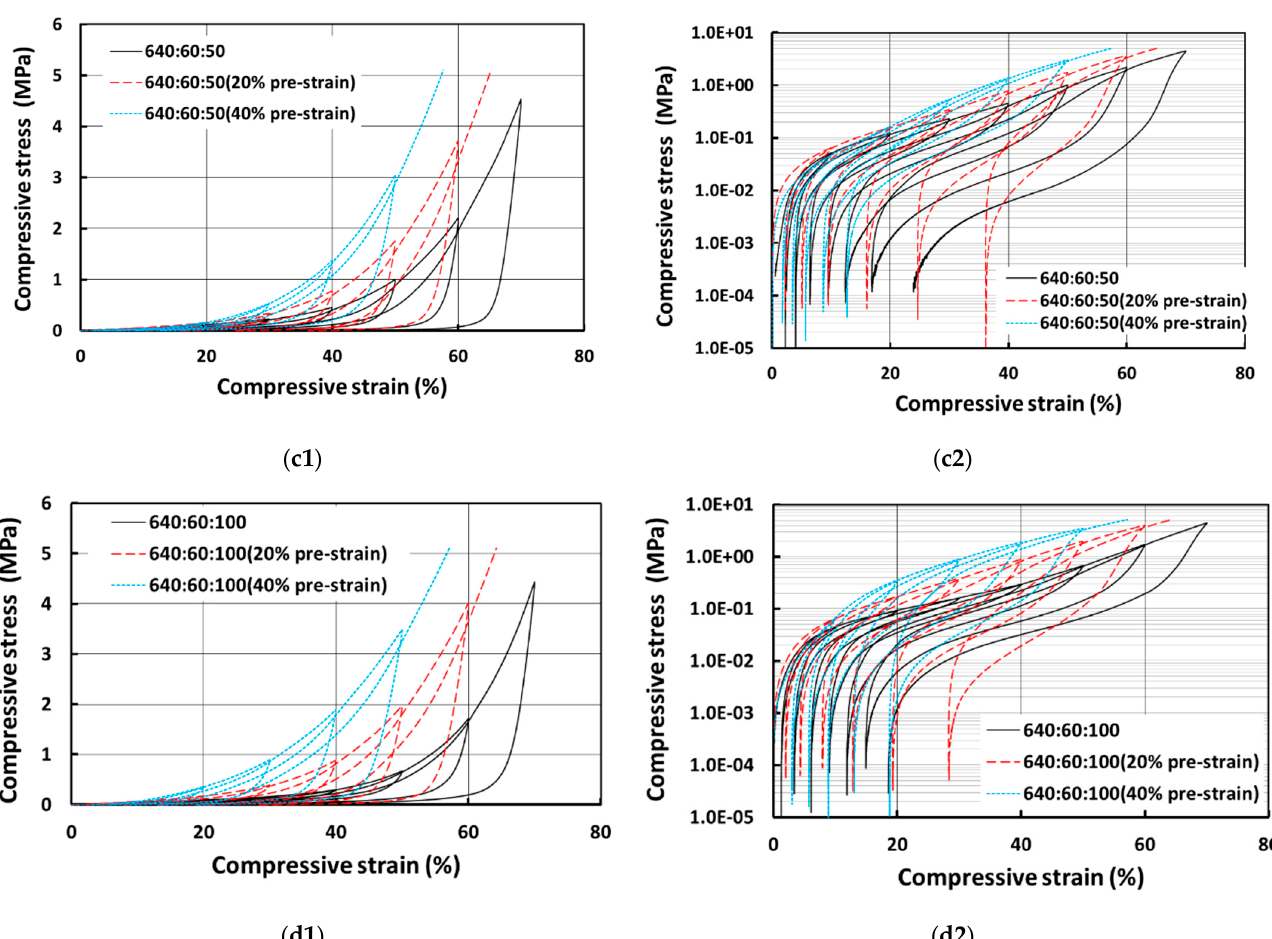
Figure 14. Compressive stress vs. strain of E640 SMH samples with 0%, 20% and 40% pre-strains; ( a1 ) for samples with 70% silicone, 30% PCL and 50% wetting hydrogel and its corresponding logarithmic plot of stress in ( a2 ); ( b1 ) for samples with 70% silicone, 30% PCL and 100% wetting hydrogel and its corresponding logarithmic plot of stress in ( b2 ); ( c1 ) for samples with 60% silicone, 40% PCL and 50% wetting hydrogel and its corresponding logarithmic plot of stress in ( c2 ); and ( d1 ) for samples with 60% silicone, 40% PCL and 100% wetting hydrogel and its corresponding logarithmic plot of stress in ( d2 ).